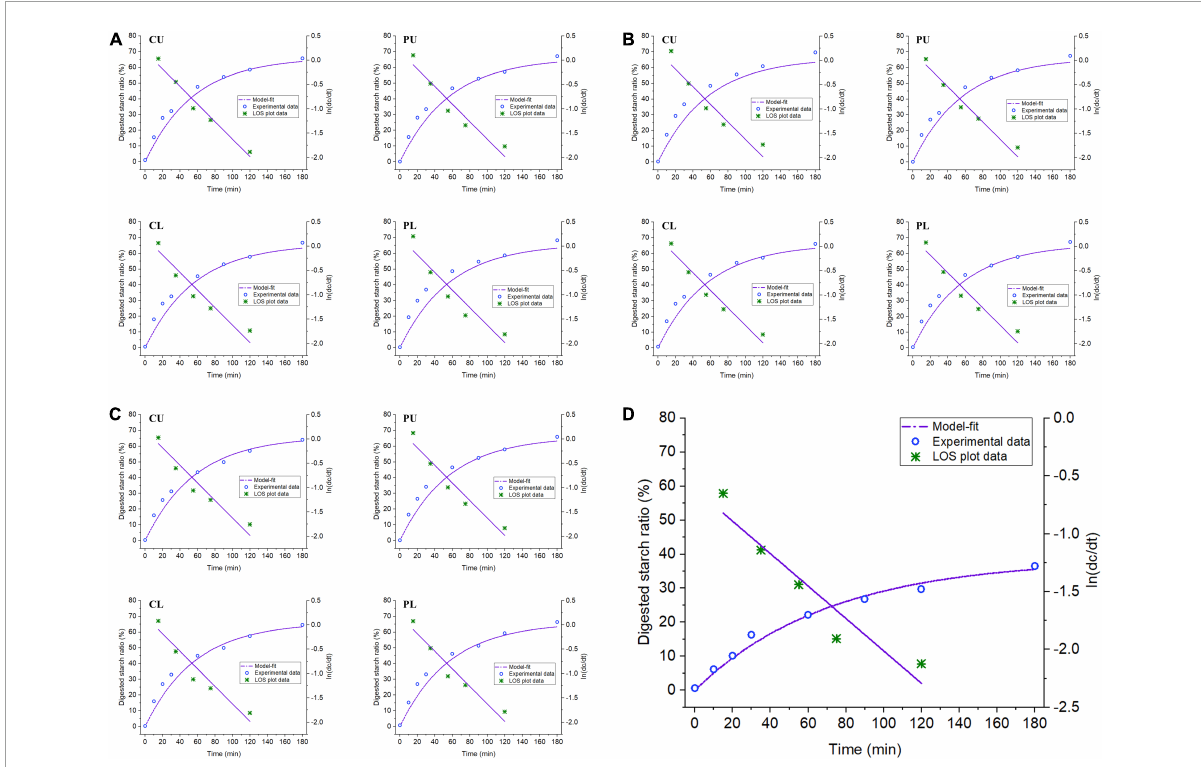
FIGURE5 Starch digestion curve and first-order kinetic fitting of raw rice and rice cooked under different heating modes. (A) Mode 1. (B) Mode 2. (C) Mode 3. (D) Untreated rice. CU, central upper layer; PU, peripheral upper layer; CL, central lower layer; and PL, peripheral lower layer.